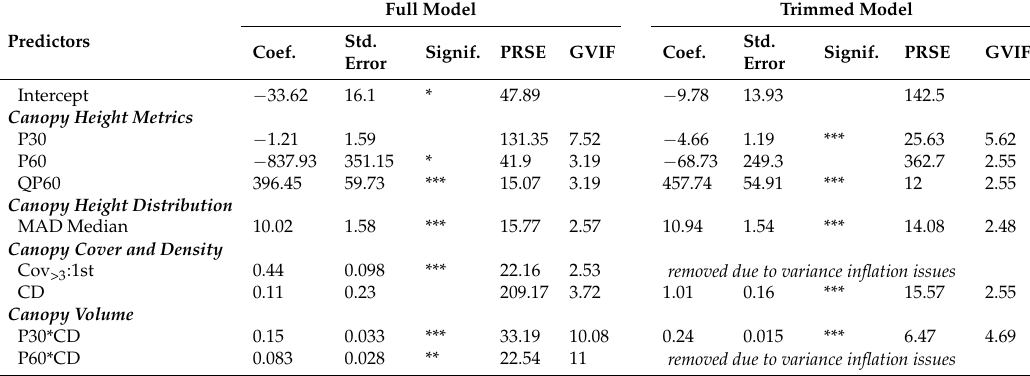
Table 6. Full and trimmed (non-transformed) AGB median probability model specifications. GVIF is the generalized variance inflation factor. The significance of the relationship between each predictor and the response is indicated as follows: * is less than 0.05, ** is less than 0.01, and *** less than 0.001; others are less than